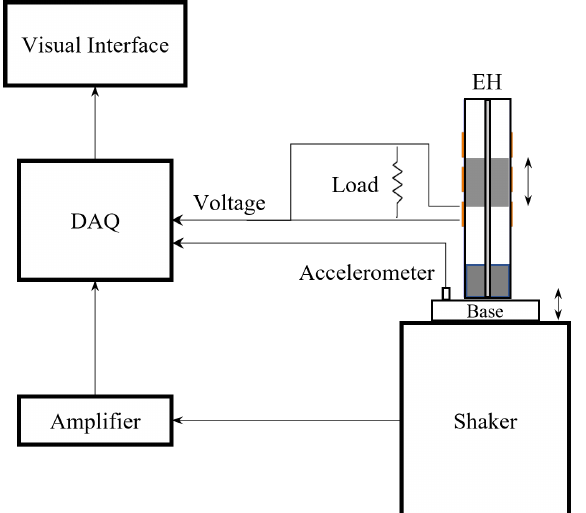
Figure 8. Experimental setup logic